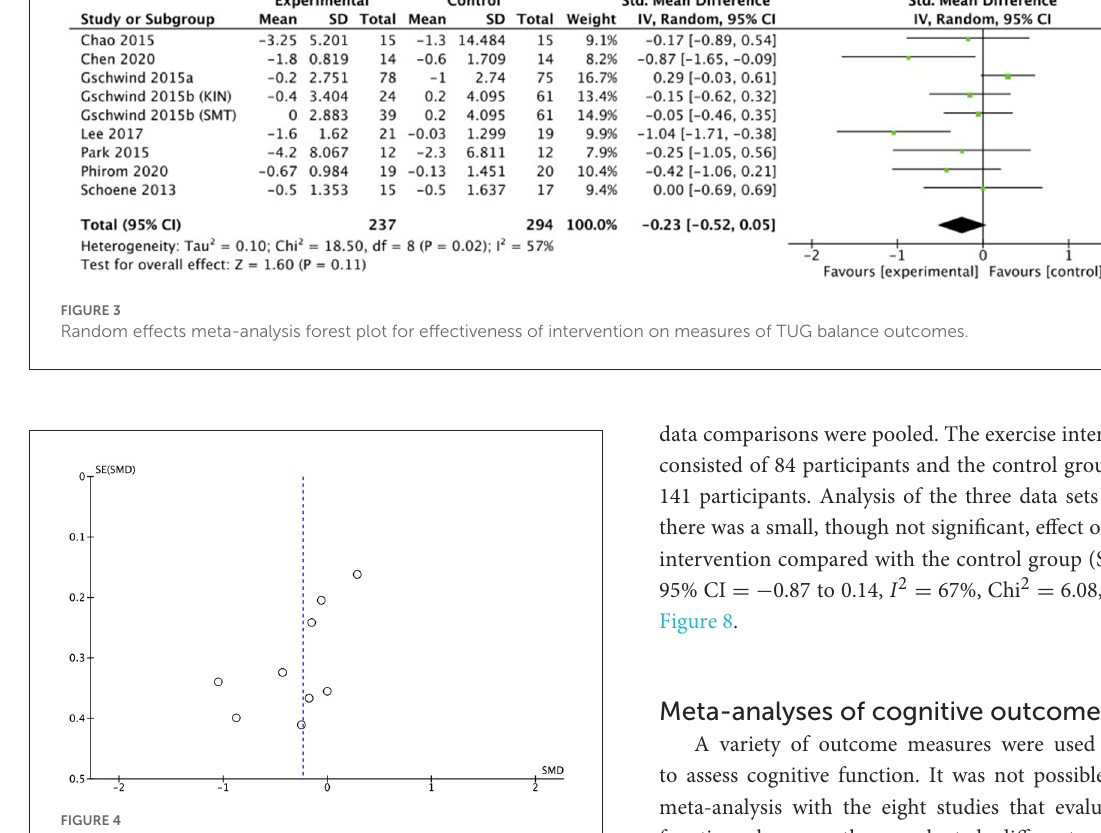
FIGURE4 Funnel plot of comparison: TUG.